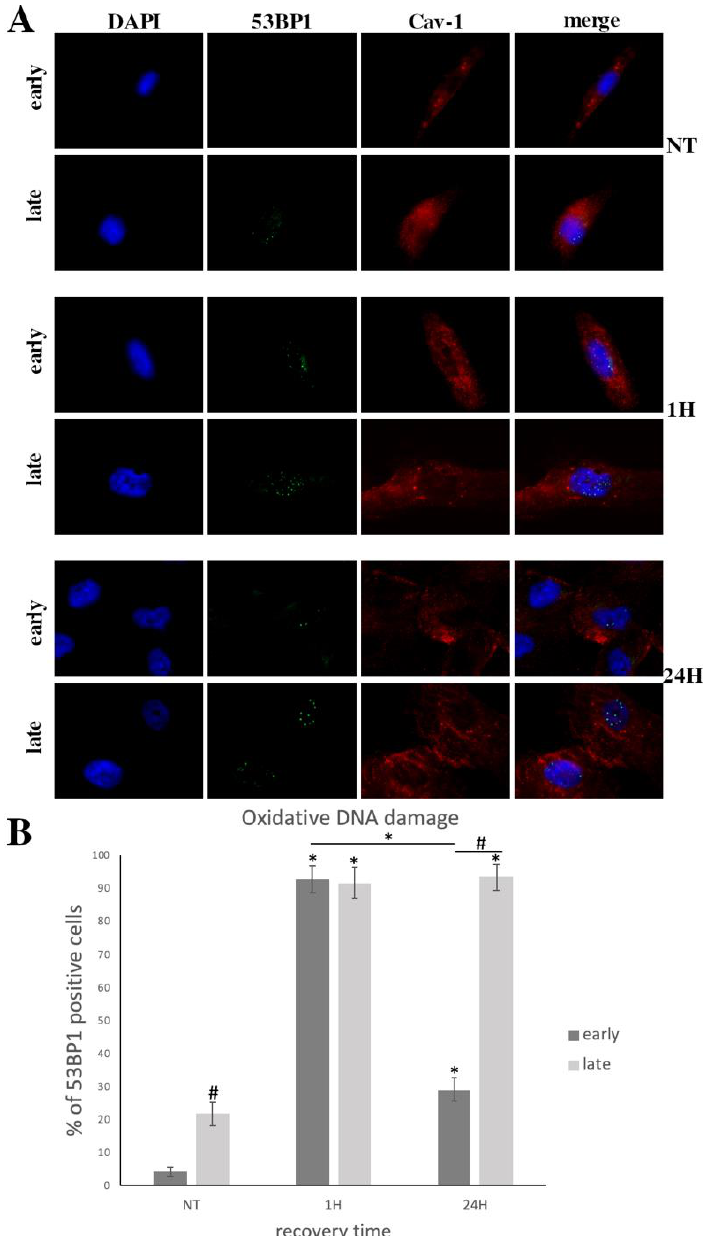
Figure 2. Late-passage cells demonstrated an inability to repair DNA damage. ( A ) Characteristic images of early- and late-passage cells where DNA damage was assessed by staining with the 53BP1 antibody and the appropriate secondary antibody (green). (blue). Cav-1 localization was also evaluated by staining with anti-cav-1 antibody and the appropriate secondary antibody (red) under normal conditions (No Treatment—NT) and at 1 h and 24 h after being treated with H 2 O 2 . (300 µ M, 30 min). Nuclei were stained with DAPI. Images were captured with the 40 × objective lens of the fluorescent microscope used. ( B ) Percentages of WJ-MSCs with 53BP1 foci from early- and late-passage cells from three donors evaluated by staining with the 53BP1 antibody under normal conditions (No Treatment—NT) and at different time points of the recovery period from the oxidative treatment (1 h and 24 h). Values shown are the means ± S.E. # p < 0.05 vs. early passage cells at the same time point and * p < 0.05 vs. NT or otherwise indicated. p values calculated using the Student t